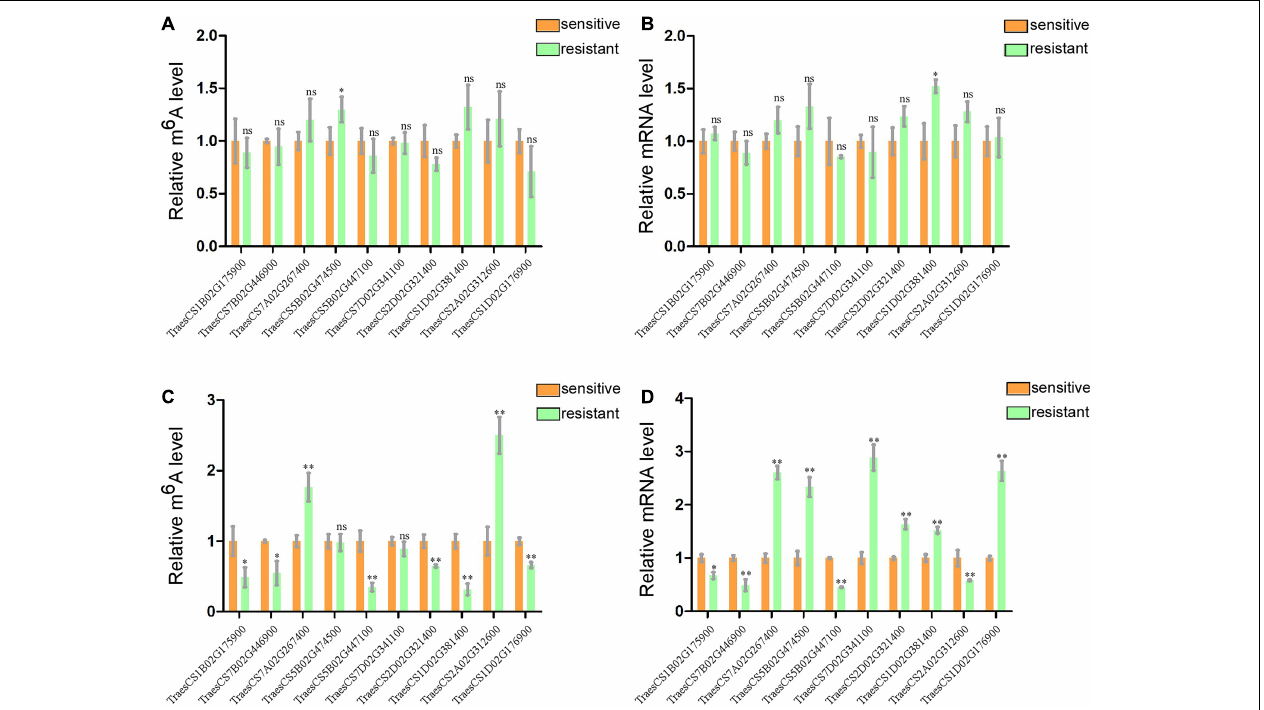
FIGURE 5 | Gene-specific m6A/normal qPCR assays. (A) m 6 A IP qPCR validation of m6A methylation level of 10 randomly selected genes from Table 1 in two healthy wheat variety plants. (B) Relative mRNA levels of the 10 genes were detected via real-time qPCR in two healthy group plants. (C) m6A methylation level of 10 randomly selected genes in WRV and WSV group respectively. (D) Relative mRNA expression level of 10 genes in WRV and WSV group plants. The levels of the 10 genes in the sensitive variety group were normalized to 1. Statistical analyses were performed using the Student’s t -test. Asterisks indicate a significant difference when compared to the control. * p < 0.05; ** p <